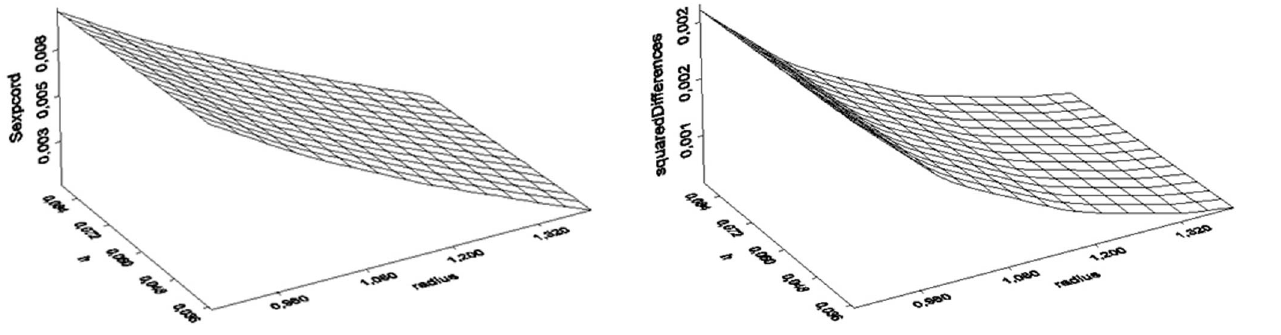
Figure 2. Three dimensional illustration of the Sexp for 1880 MHz vs h and radius.